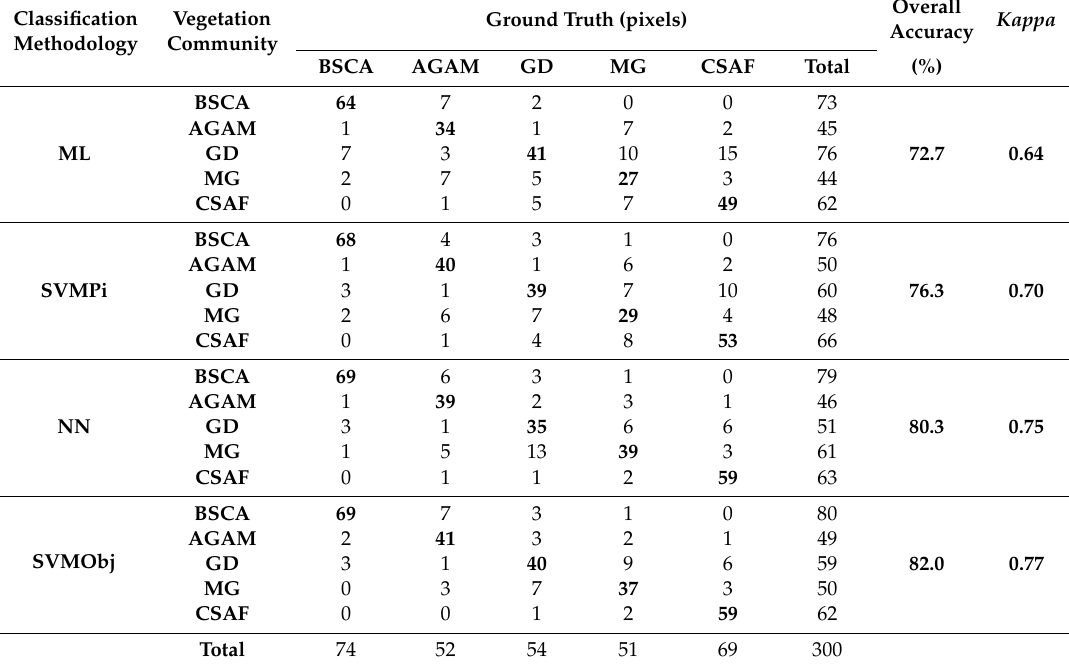
Table 3. Confusion matrices for each of the image classification methodologies. For abbreviations, see main